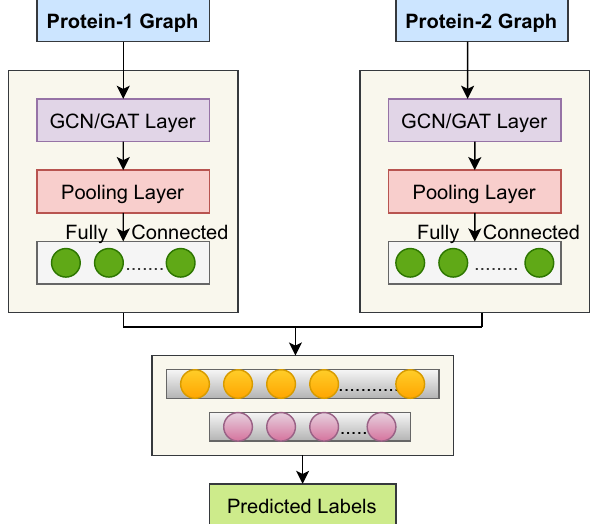
Figure 2. Illustration of the proposed